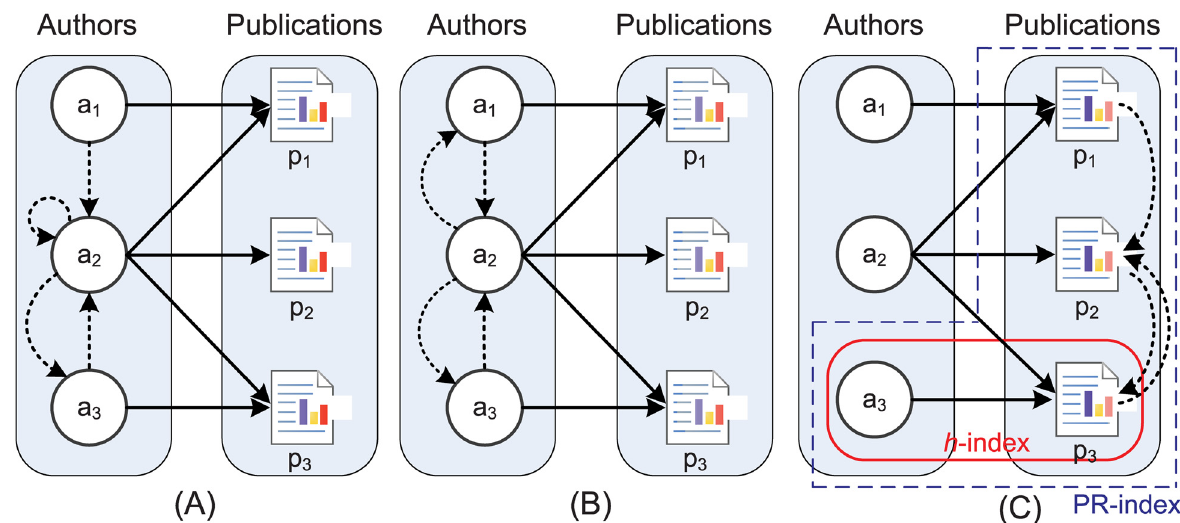
Fig 1. Three kinds of relationship in the academic research field. a 1, a 2, a 3 denote three authors, p 1 , p 2 , p 3 denote published papers. A black solid line means that an author published a paper. (a) illustrates the author citation relationship. The dashed arrow from a 1 to a 2 denotes that a 1 cited a 2 in a paper. (b) represents co-authorship among authors. There are two directed dashed edges between a 1 and a 2 which means that a 1 has co-authored with a 2 . (c) represents for the publication citation relationship. A directed dashed edge from p 1 to p 2 means p 1 has cited p 2